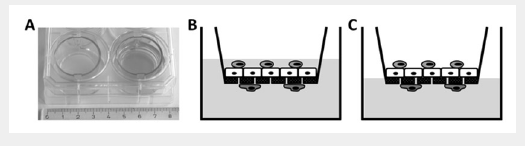
Two chamber cell culture system. A conventional two chamber cell culture system in a six-well culture dish. Cells are grown on a porous polyethylene terephthalate (PET) membrane. For reference, the well on the left does not contain medium. B/C Triple cell co-culture model of the human air-liquid barrier consisting of macrophages (light gray, top), epithelial cells (white, middle) and dendritic cells (dark grey, bottom). The cells can be kept submerged (B) or at the air-liquid interface